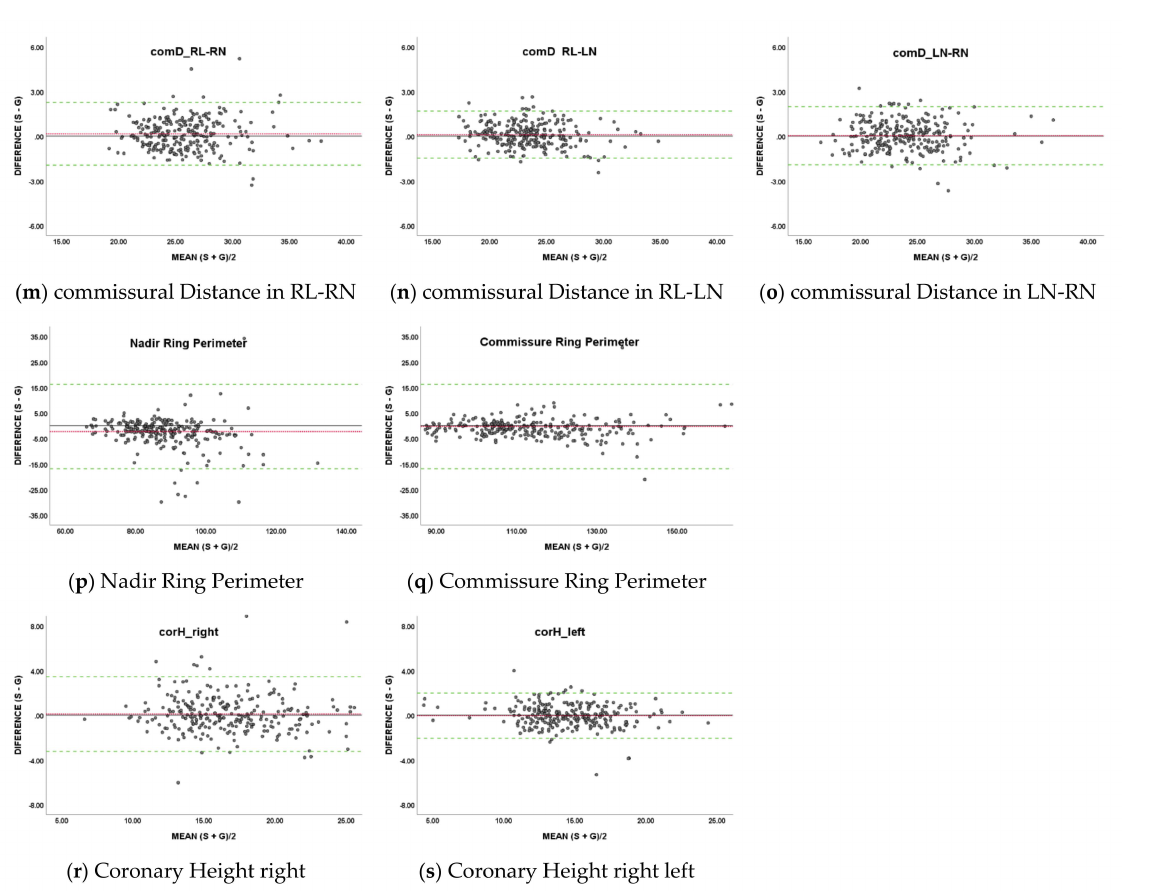
Figure A2. Bland–Altman plots for each measurement item: ( a ) effective Height in RCC, ( b ) effective Height in LCC, ( c ) effective Height in NCC, ( d ) geometric Height in RCC, ( e ) geometric Height in LCC, ( f ) geometric Height in NCC, ( g ) cusp insertion Length in RCC, ( h ) cusp insertion Length in LCC, ( i ) cusp insertion Length in NCC, ( j ) Free Margin Length in RCC, ( k ) Free Margin Length in LCC, ( l ) Free Margin Length in NCC, ( m ) commissural Distance in RL-RN, ( n ) commissural Distance in RL-LN, ( o ) commissural Distance in LN-RN, ( p ) Nadir Ring Perimeter, ( q ) Commissure Ring Perimeter, ( r ) Coronary Height right, ( s ) Coronary Height right left. Red dashed lines indicate the mean of the difference, the Green dashed lines indicate the 1.96 SD intervals as the limits of